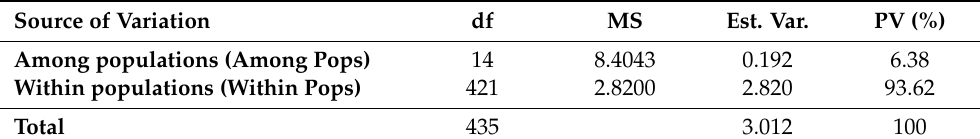
Table 5. Analysis of molecular variance (AMOVA) performed for 15 populations of A. aculeatum collected in the state of Amazonas.